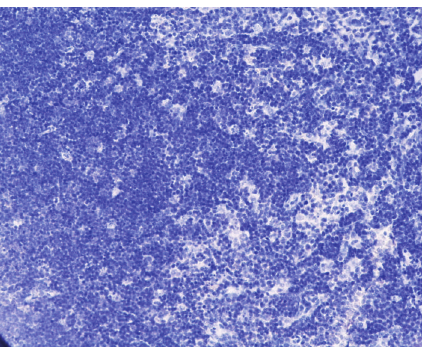
Table 4: Comparison of pathological score of the thymus ( M ( Q R )).